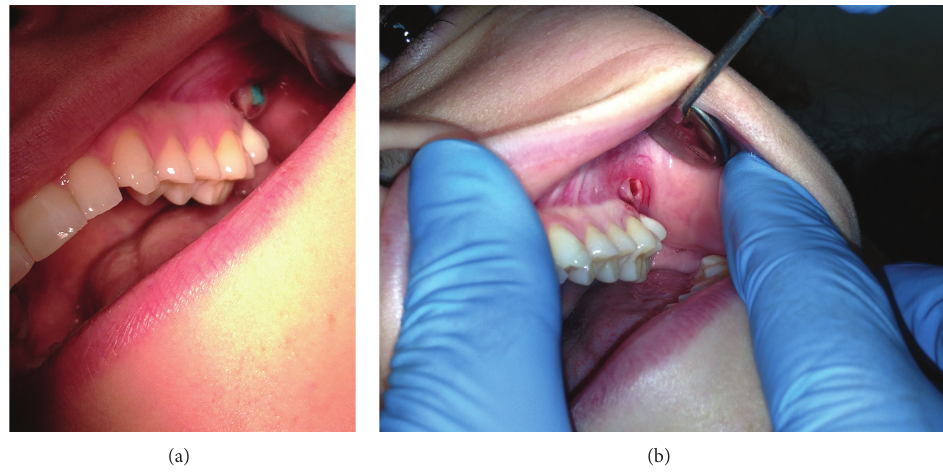
Figure 5: (a) and (b) Bluish mass found in the mucosal tissue and removed by excision.